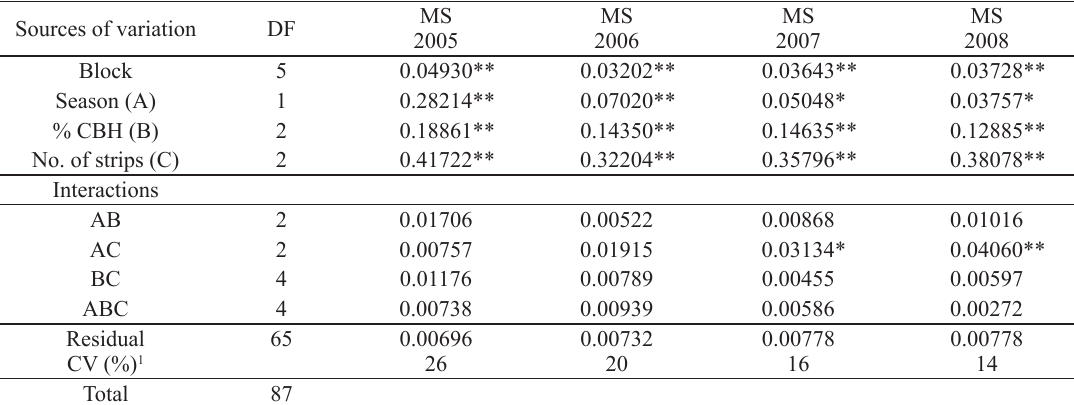
ANOVA test results of percentage of bark recovery in Drimys brasiliensis , in 2005, 2006, 2007 and 2008, from experiment one.